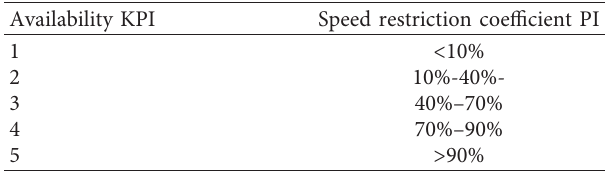
Table 4: Correlation between availability KPI qualitative scale and speed restriction coefficient (SRC) PI quantitative scale, adapted from [34].